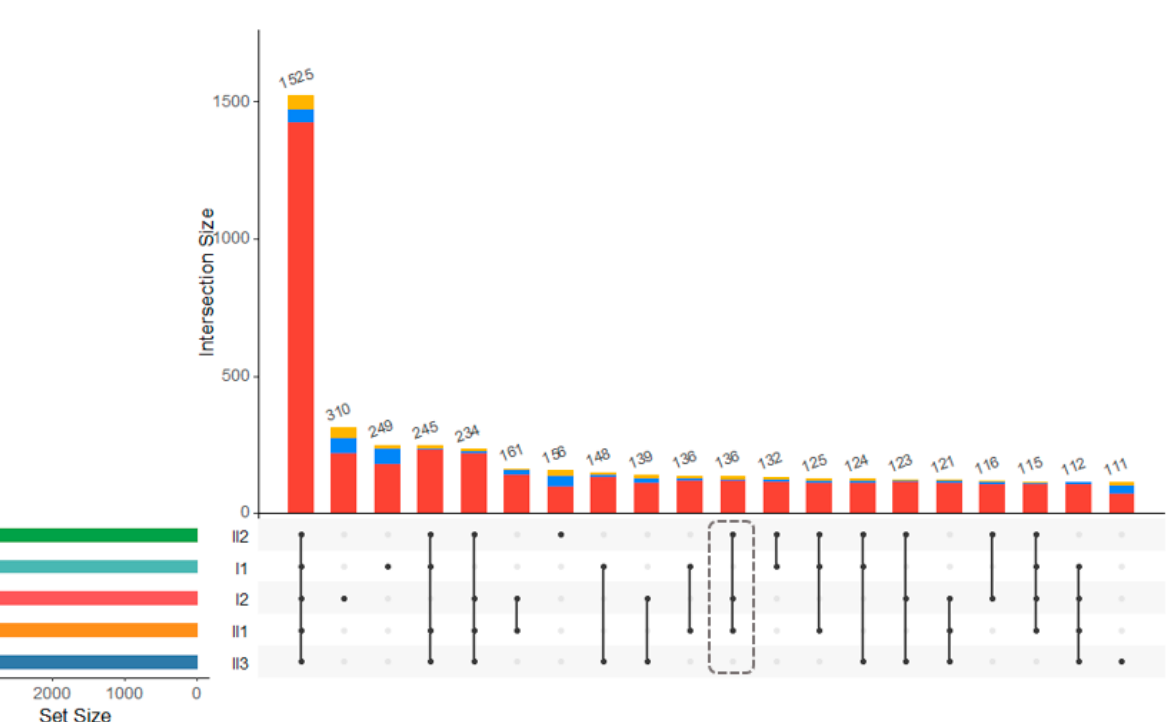
Figure 2. UpSet plot of variant intersection between the family members. Dotted line showing the shared 136 events in affected family members.